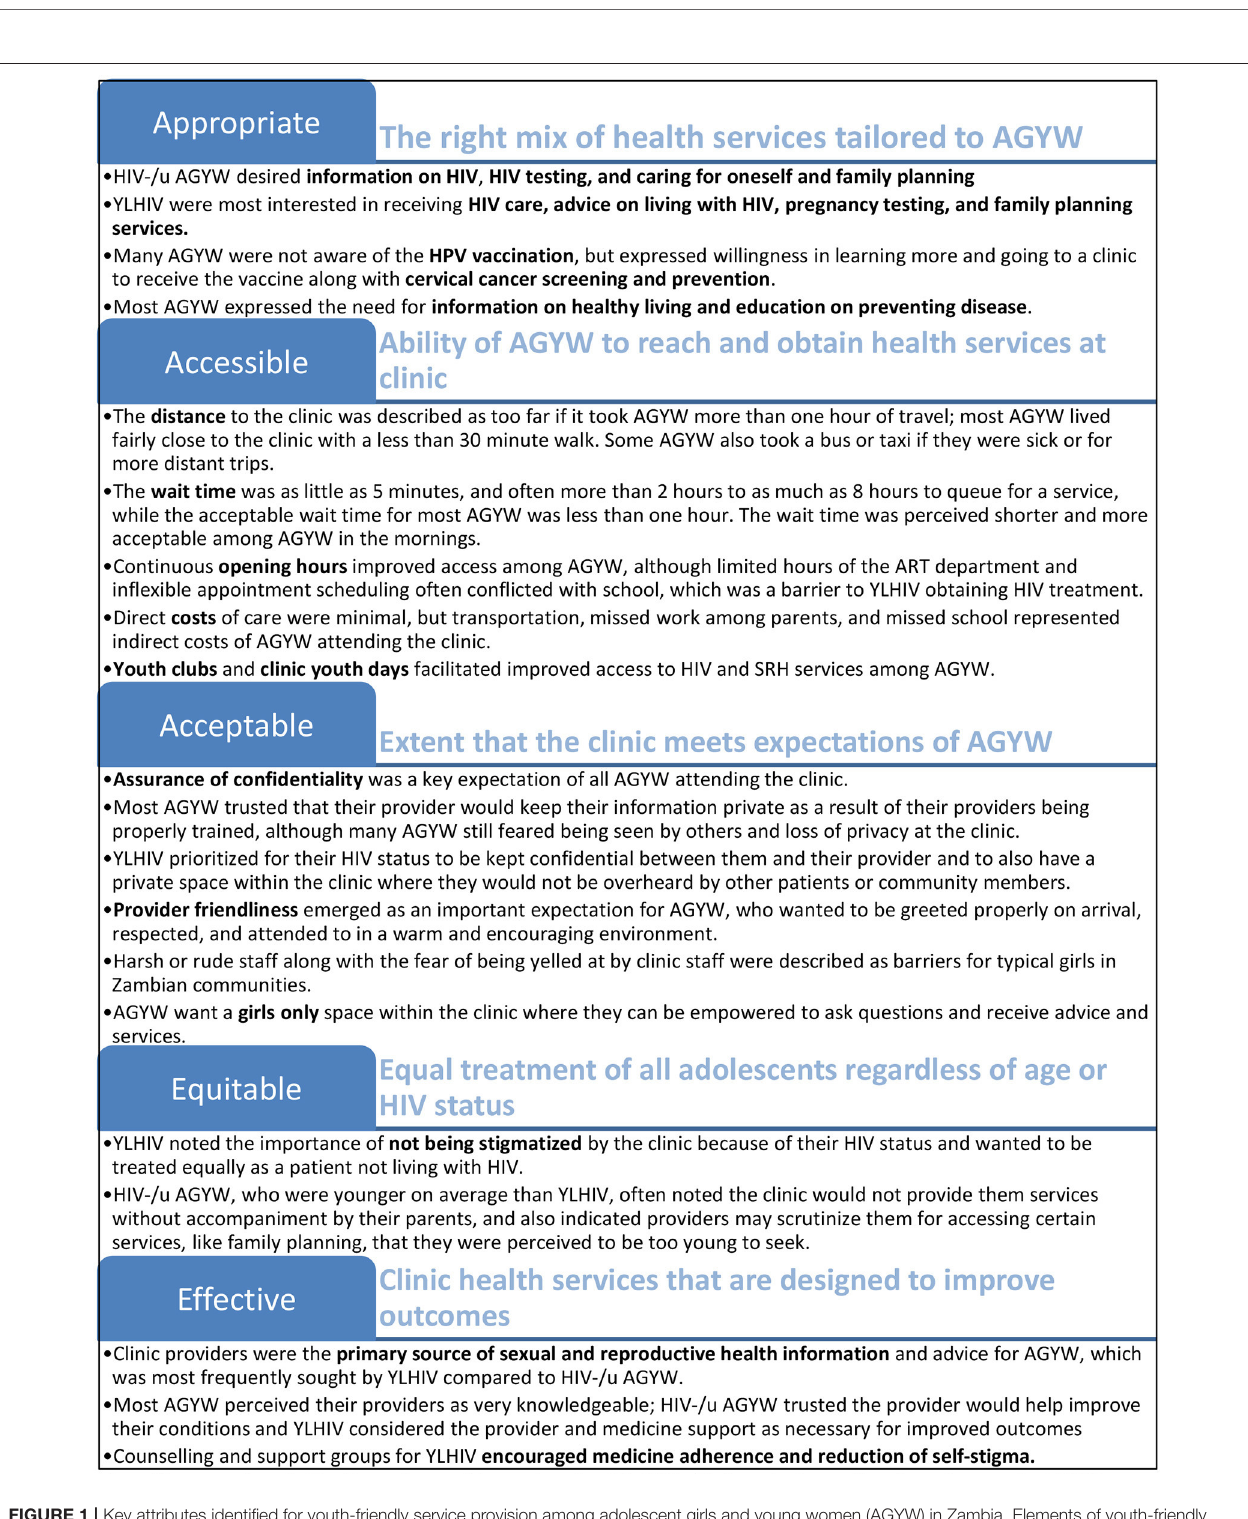
Frontiers in Global Women’s Health |